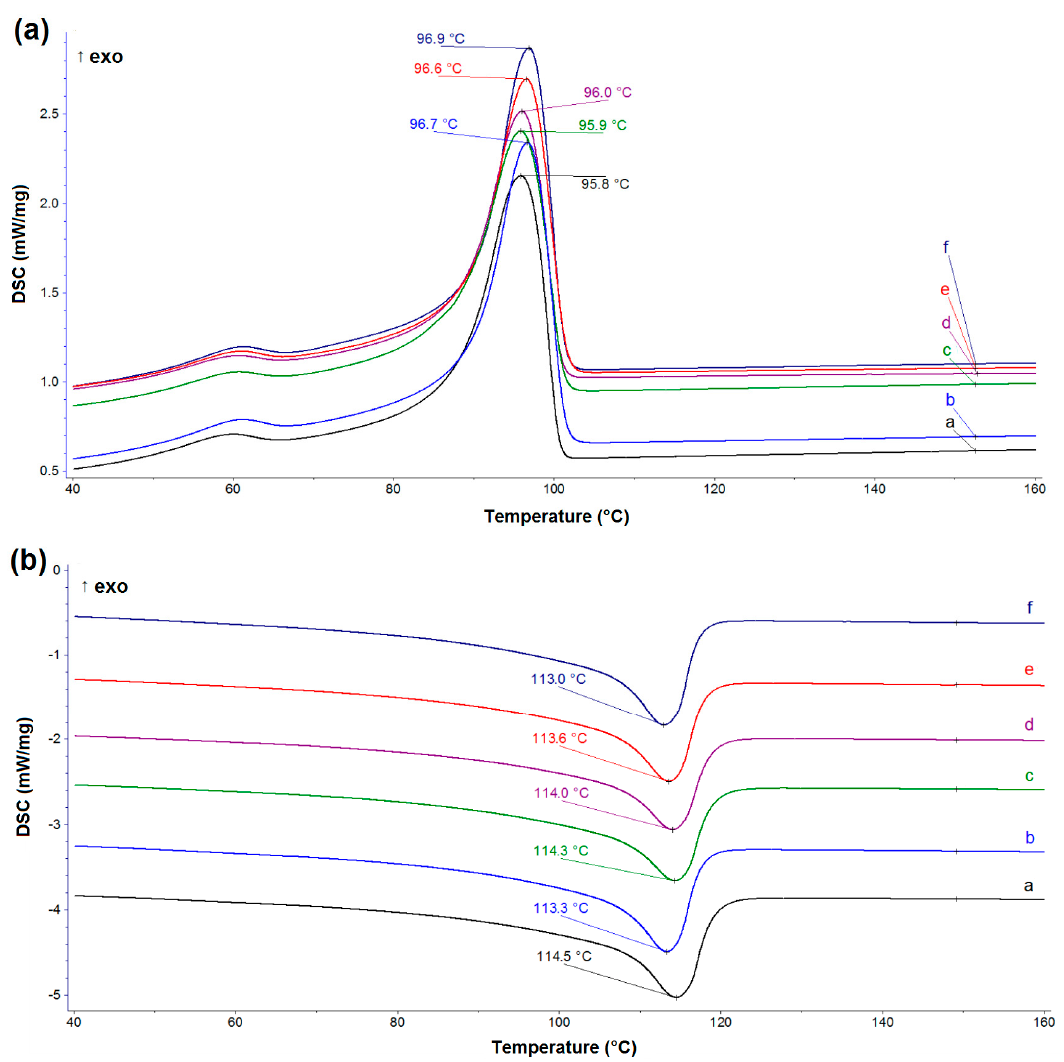
Figure 3. ( a ) The DSC curves obtained during the cooling of ( a ) pristine LDPE, ( b ) LDPE/MgO, ( c ) LDPE/MgO-L (5:1 wt/wt), ( d ) LDPE/MgO-L (1:1 wt/wt), ( e ) LDPE/MgO-L (1:5 wt/wt), and ( f ) LDPE/lignin. ( b ) The DSC curves obtained during the second heating.